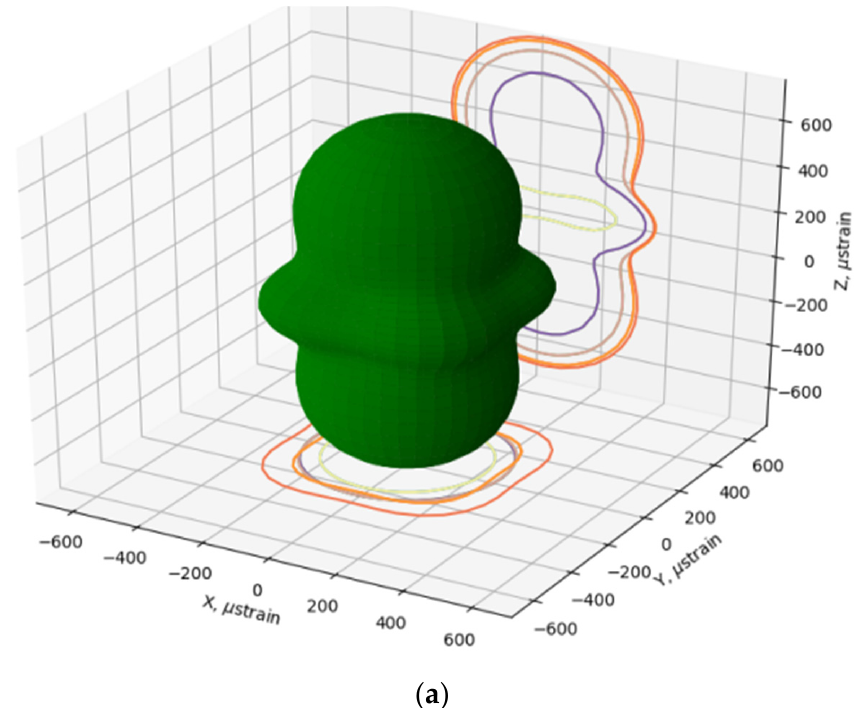
Figure 2. Lattice parameters a, c as a function of temperature—( a ), as a function of time at 250 °C—( b ) obtained from XRD patterns for LCNO_01_q in He flow.